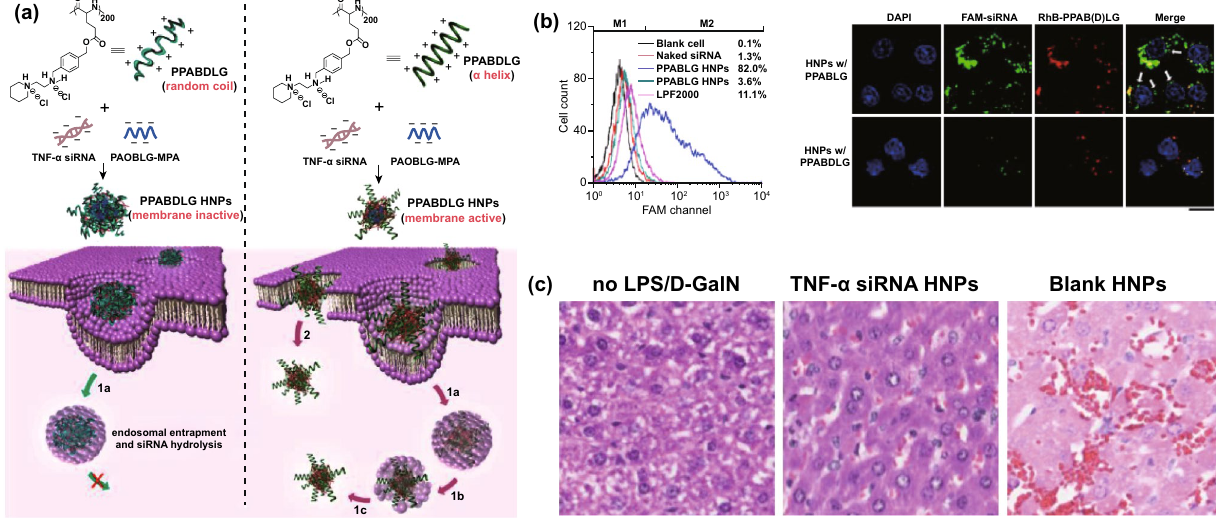
Fig. 19 TNF-α siRNA-delivering helical polypeptide hybrid nanoparticles (HNPs) protect animals against hepatic sepsis. a Schematic drawing illustrating the intracellular kinetics of nonhelical PPABDLG/PAOBLG-MPA/siRNA or PPABLG/PAOBLG-MPA/siRNA HNPs, highlighting the helical conformation-dependent intracellular delivery to induce enhanced membrane disruption and endosomal escape. b Flow cytometric analyses (left) and CLSM (right) demonstrated the intracellular delivery capacity of HNPs to macrophage RAW264.7. c HE-stained liver sec- tions from mice receiving HNPs at 50 μg of siRNA/kg. Reproduced with permission from Ref. [246]. Copyright 2016 American Chemical